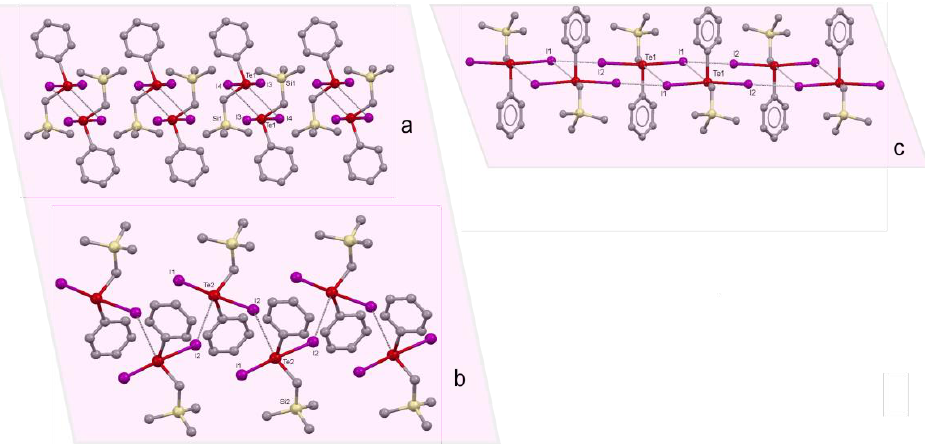
Figure 7. Fragment of packing of two polymorphic forms of phenyl-(trimethylsilylmethyl)-tellurium diiodide: ( a , b )—dimer/catemer parallel chains (ISALOE01, C2/c , Z’ = 2) and ( c )—dimeric (ISALOE, P-1 , Z’ = 1) ( c ), showing the parallel chains of Te---I ChB stabilized centrosymmetric dimers ( a ) and catemer ( b ) in C2/c form and only associated dimers in P-1 form ( c ). Hydrogen atoms are omitted for clarity. Notice that dimeric chains ( a ) and ( c ) have a different packing pattern.